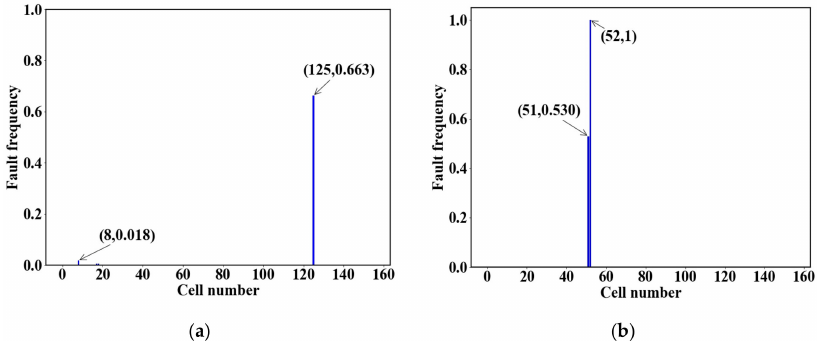
Figure 10. Fault frequencies of battery cells in: ( a ) vehicle 1; ( b ) vehicle